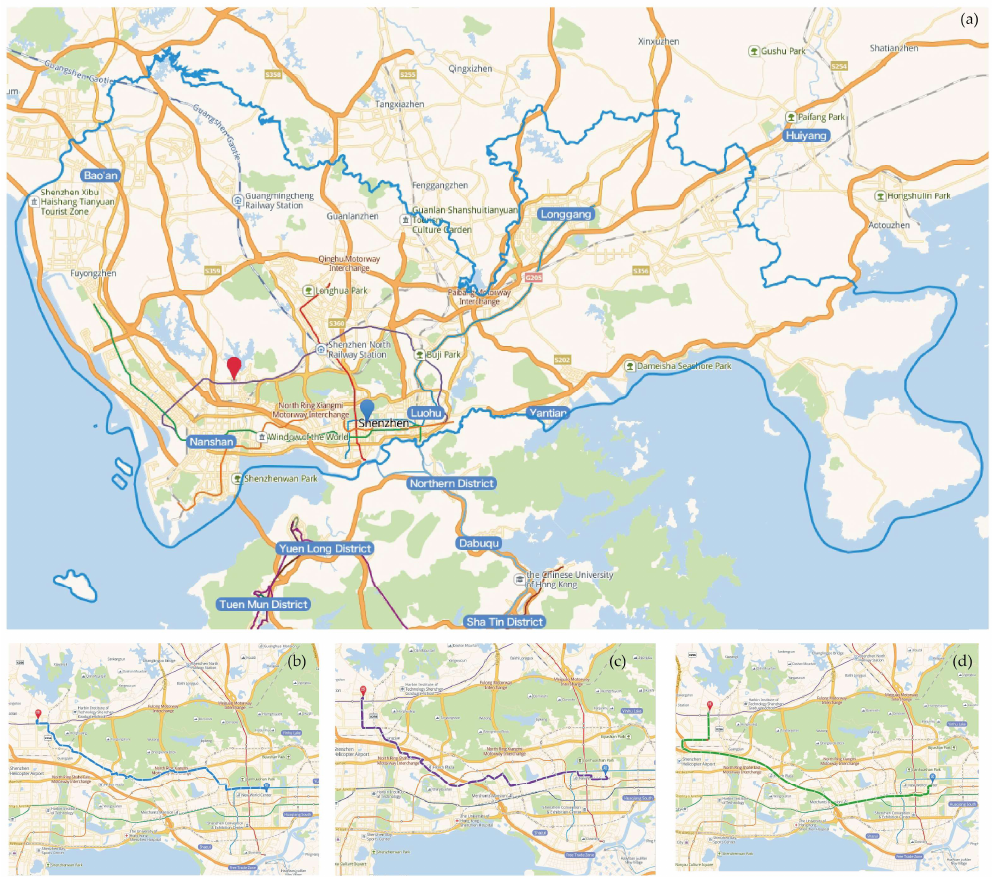
Figure 2. Screenshot of road network in Shenzhen and an example of four types of distance: ( a ) the Euclidian distance; ( b ) the walking distance; ( c ) the riding distance; ( d ) the driving distance. Datasource: Amap from AutoNavi Software Co., Ltd. (Beijing, China) Origin (blue marker) = (114.070173, 22.546626), Destination (red marker) = (113.948956,